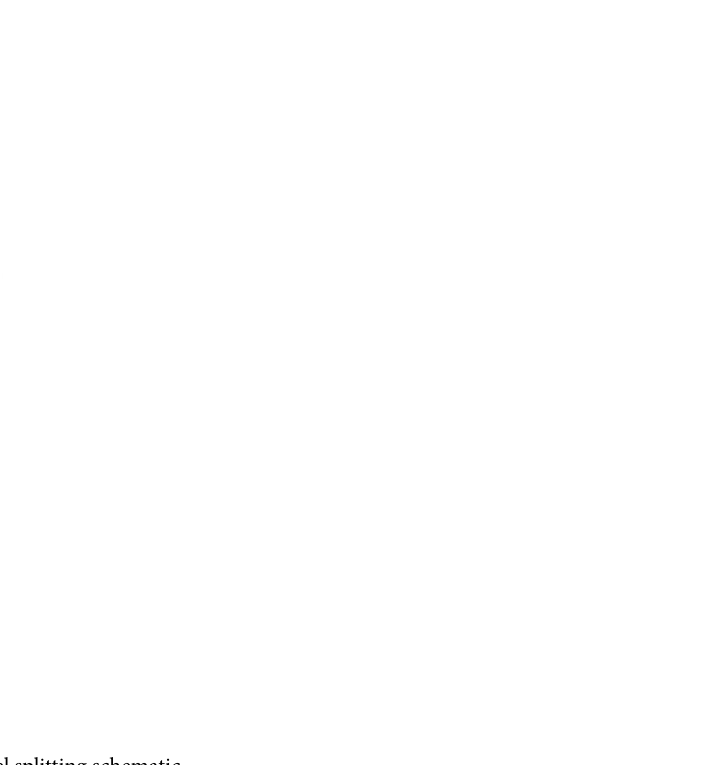
Figure 5. In this model, the convolutional layer of ShuffleNetV2 is responsible for downsampling, and a modified ViT module is inserted before and after the last ShuffleNetV2 layer to extract global features.